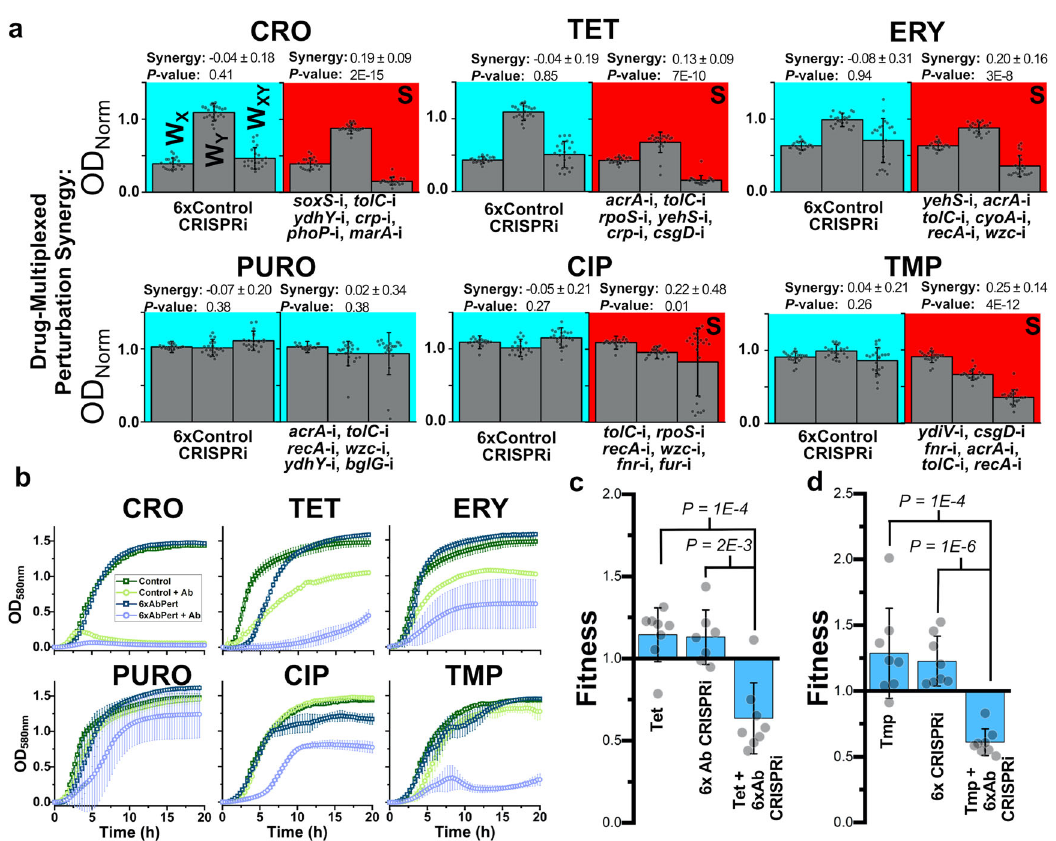
Fig. 4 Multiplexed CRISPRi perturbations further potentiate antibiotic treatment. a The six individual gene perturbations designed for each antibiotic were multiplexed into one strain, and synergy was again screened for (right column). A control strain with six nonsense rfp perturbations was also created to show that harboring multiple targets did not in fl uence these results (left column). Strain ODs ’ after 16 h of growth were quanti fi ed, and these values were used to calculate fi tness. For the left column under each antibiotic, growth of the control single rfp perturbation strain during exposure to the listed antibiotic, growth of the six rfp perturbation strain with no antibiotic, growth of the six rfp perturbation strain in the presence of the listed antibiotic were all normalized to the growth of the single rfp control strain without exposure to antibiotic, giving W X , W Y , and W XY , respectively. The same occurred on the right column, except the control single rfp perturbation strain was replaced with the six rfp perturbation strain, and the six rfp perturbation strain was replaced with the six multiplexed gene perturbation strains designed for each antibiotic. Statistically signi fi cant synergy is indicated by a red background and the letter “ S ” and additive by a blue background. Error bars represent standard deviation of 22 biological replicates and gray circles represent individual biological replicates. Synergy values are listed above each graph with signi fi cance. b Growth curves of these multiplexed CRISPRi strains in the presence of each antibiotic. Error bars represent standard deviation of three biological replicates. A more thorough fi tness assay using competition was applied to more precisely estimate the fi tness impacts of multiplexed perturbations for c TET and d TMP. Competition was performed for these strains against a fl uorescent control strain harboring one nonsense CRISPRi perturbation in either the presence or absence of antibiotic treatment. A control competition of the 6× rfp perturbation strain against the fl uorescent control was also performed in the presence of antibiotic. Fitness was calculated using the standard Malthusian fi tness equation (see “ Methods ” section). Error bars represent standard deviation of eight biological